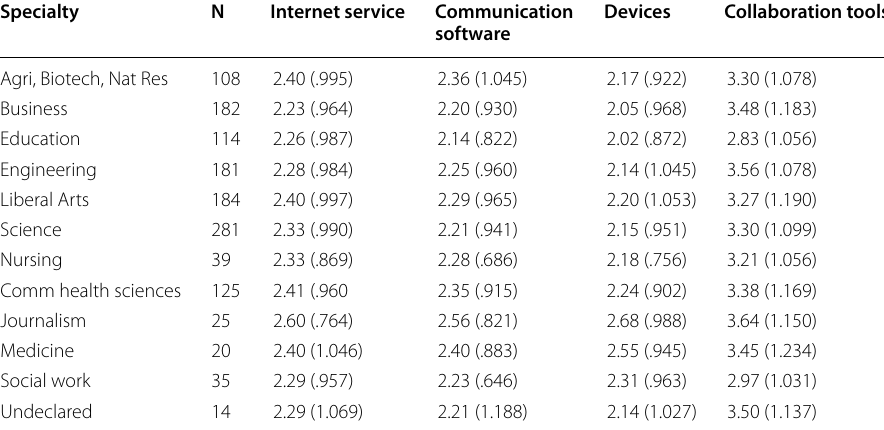
Table 5 Means (standard deviations) across specialties for the four access items Specialty